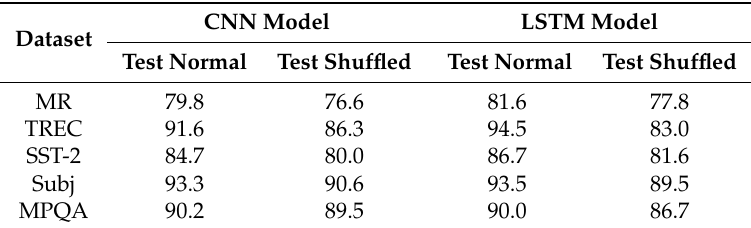
Table 2. Accuracy of the CNN and LSTM models on different